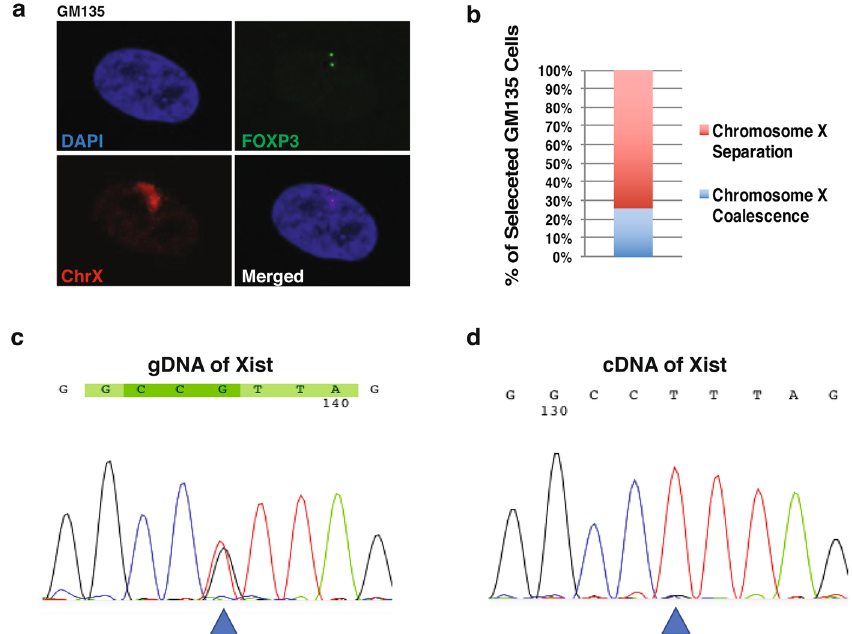
Figure 3. During X coalescence, Xist localization changes on the X chromosomes as opposed to Xist gene loci reactivation on the active X chromosome. ( a ) 3D DNA FISH maximum intensity projections of an 8-azaguanine selected human GM135 nuclei labeled with DAPI (blue), chromosome X (red), and X-linked gene loci, FOXP3 (green) during X coalescence. ( b ) Frequency of chromosome X coalescence in selected GM135 cells, 100 nuclei analyzed. ( c ) Xist genomic sequence containing a known single nucleotide polymorphism site (SNP rs16992443) (blue triangle) isolated from selected GM135 cells. ( d ) cDNA sequence of Xist, generated from RNA, isolated from selected GM135 cells. Location of known Xist SNP site (blue